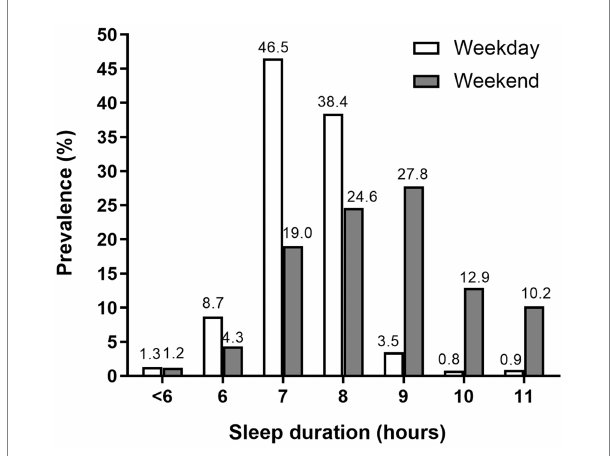
FIGURE 1 Distribution of weekday and weekend total sleep time (TST) in 2,346 Chinese adolescents aged 13–14